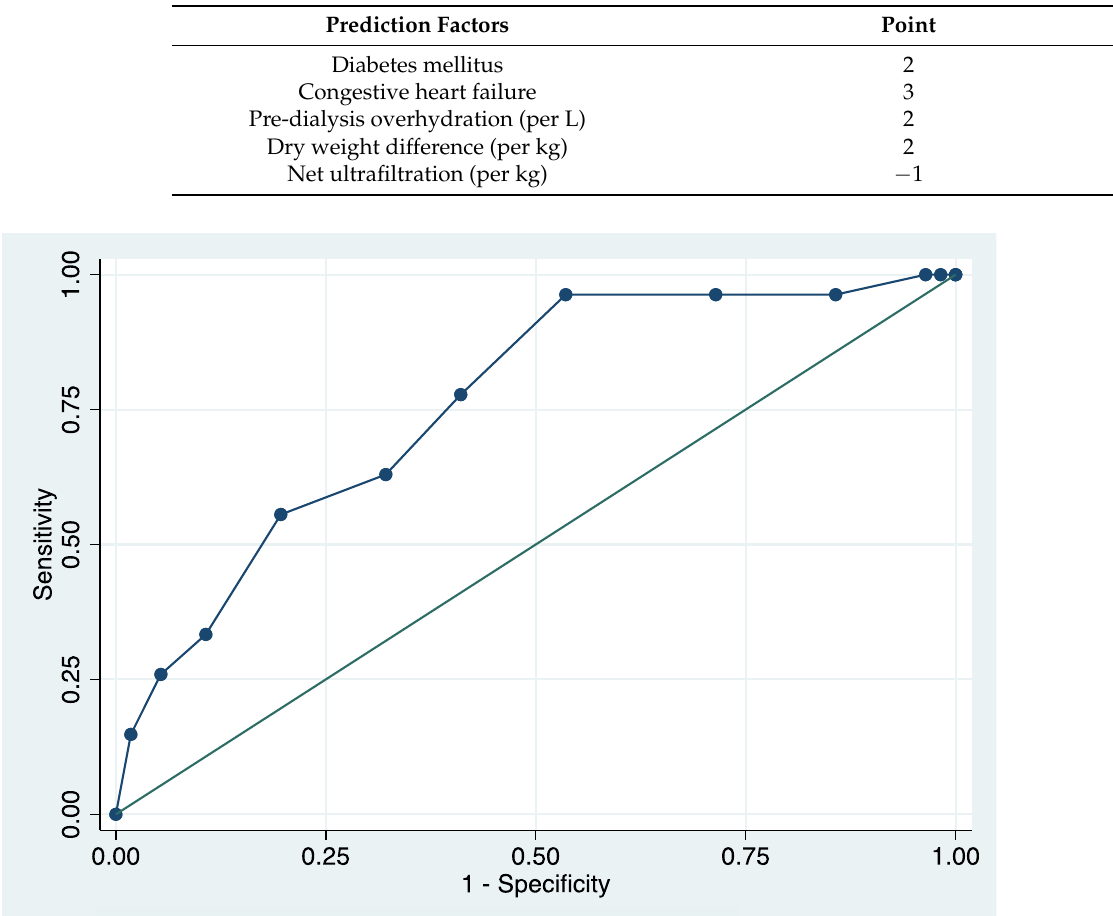
Table 5. The final model of the prediction score for unsuccessful reductions in hemodialysis frequency.